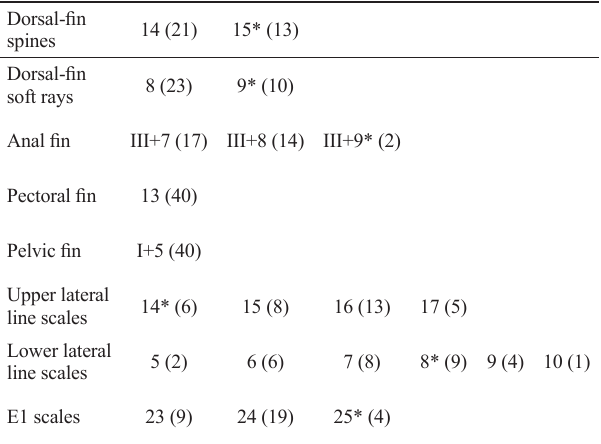
Table 1. Frequency distribution of meristic characters of paratypes and holotype* of Gymnogeophagus terrapurpura, total n = 40; (number of specimens).